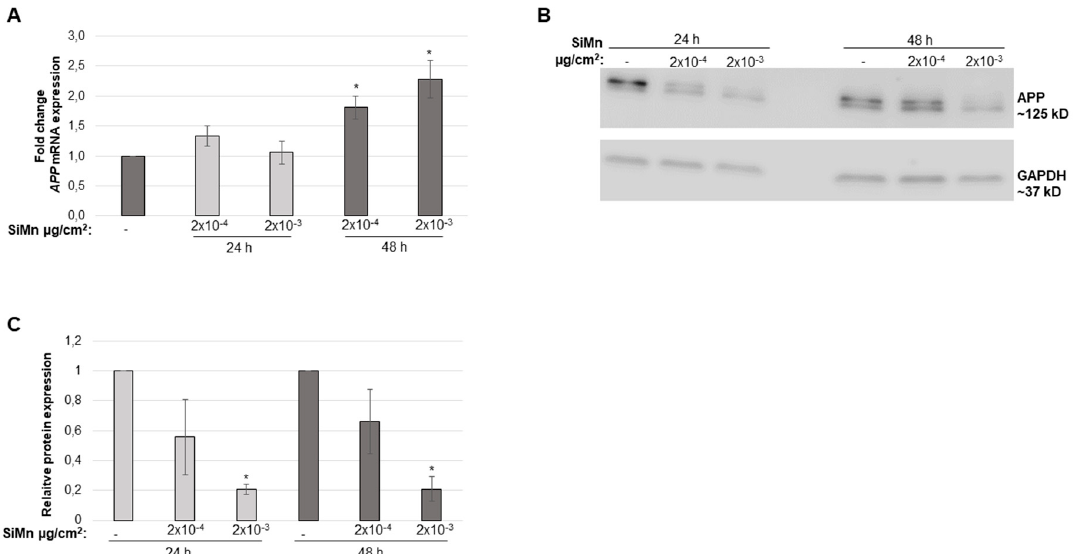
Figure 3. SiMn-induced cytotoxicity is dose and time dependent and affects apoptosis-related proteins. ( A ) Astrocytoma cells were grown and exposed to sham or to SiMn dust at the indicated concentrations for 24, 48 and 72 h before measurement of cellular cytotoxicity. Cell viability of sham-treated cells was set to 100%. An average of three independent experiments in triplicate is shown. ( B ) The expression levels of 35 proteins related to or involved in apoptosis were analyzed using the Proteome Profiler™ Human Apoptosis Array Kit. The results from three independent experiments were quantified and significant changes ( p ≤ 0.05) in fold change related to control-exposed cells are shown in the bar graphs. A fold increase or decrease of 1.5 was set as cut-off and only the results for those proteins are shown. Error bars: standard error (SE).